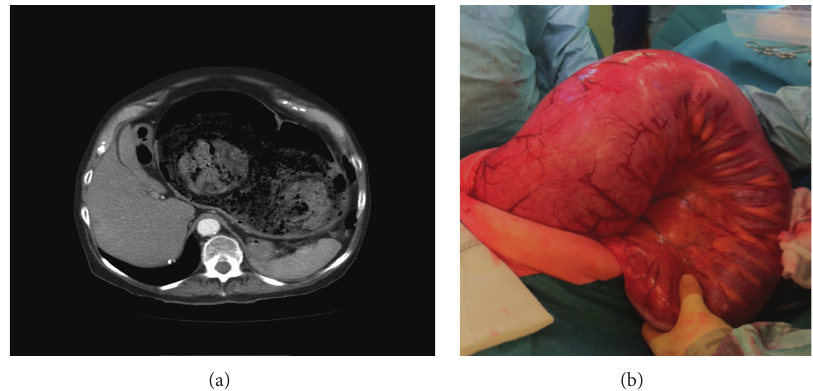
Figure 1: (a) CT scan showing grossly distended sigmoid containing faeces. (b) Sigmoid colon at laparotomy. Her renal function normalised, and she made an uneventful recovery and was discharged 10 days after the